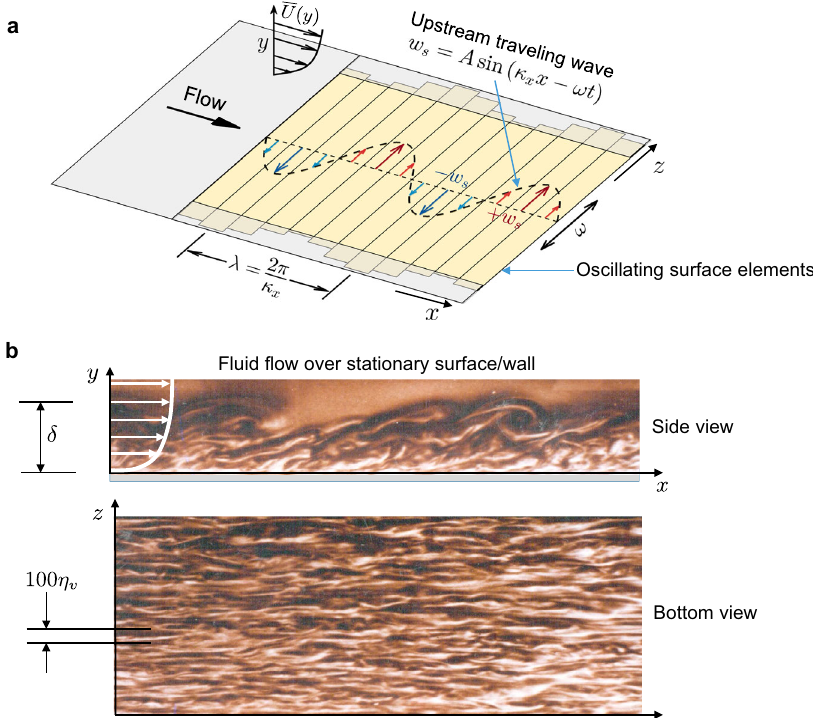
Fig. 1 Oscillating surface and turbulent fl ow scales. a Schematic of the actuation scheme: an upstream travelling wave of spanwise velocity w s and wavelength λ is created by synchronously sliding elements (slats) embedded in the surface at a frequency ω , interacting with a boundary layer fl ow with mean velocity pro fi le U ð y Þ . b Distinct regions of large- and small-scale turbulence are evident in this visualization of fl uid fl ow at Re τ ¼ 500 over a stationary surface (courtesy of D. Coles). (Top) A side view reveals how, in outer regions (farther from the surface), large-scale motions scale with the thickness δ of the boundary layer. (Bottom) In the corresponding view through the boundary layer from below, small-scale streamwise streaks are prominent close to the surface and have an average spanwise spacing of 100 η v , where η v ¼ ν = u τ is the viscous length (ref. 27 ; see 0